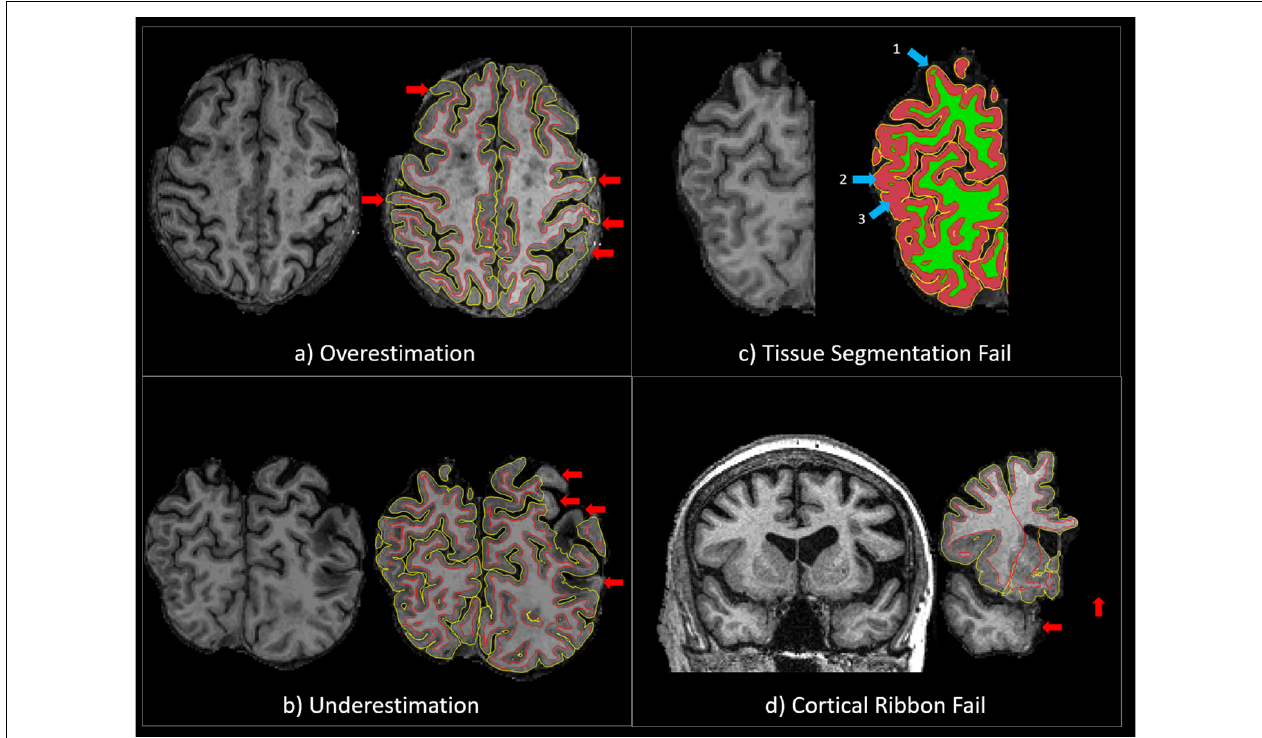
FIGURE 1 | (a) An example of a QC “fail” rating due to significant overestimation of the cortical ribbon segmentation. The red arrows point to areas where the cortical ribbon segmentation erroneously classified significant areas of non-brain matter, such as the dura mater or skull, as cortex. (b) An example of a QC “fail” rating due to significant underestimation of the cortical ribbon segmentation. The red arrows point to areas where the cortical ribbon segmentation erroneously removed significant areas of the brain. (c) An example of a QC “fail” rating due to significant tissue segmentation errors. The 1st blue arrow points to an area where GM was misclassified as WM, and the 2nd and 3rd blue arrows point to areas WM was misclassified as GM. (d) An example of a QC “fail” rating due the complete absence of a cortical ribbon for an entire brain lobule or hemisphere. The red arrows point to areas of the brain (temporal lobe and one entire hemisphere) that have been erroneously